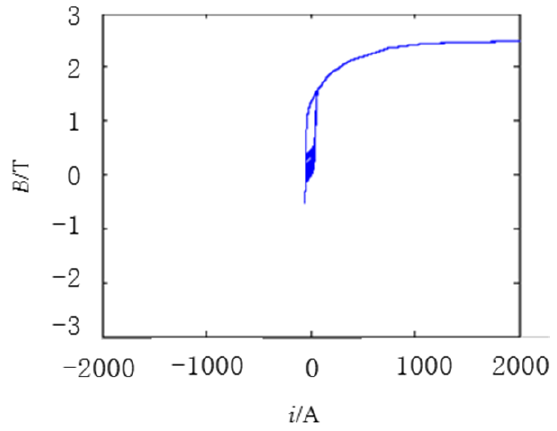
Figure 9. Magnetization curve of the transformer.